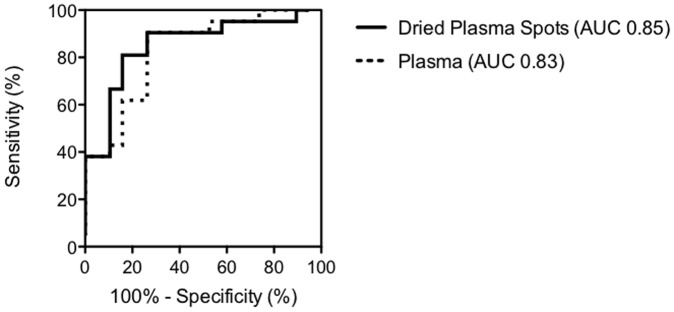
A comparison of Receiver Operation Characteristic Curves of IP-10 determined in dried plasma spots and plasma.Analysis included samples from 21 patients with cirrhosis (regarded as cases) and 19 patients with no/mild fibrosis (regarded controls in the analysis). The Area Under the Curve reflects the markers’ ability to differentiate between the two groups of patients. There was no significant difference between the two methods.